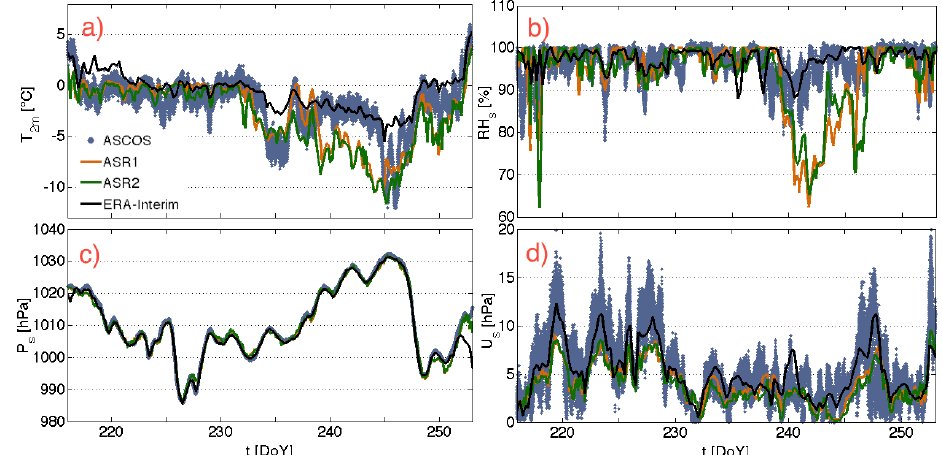
Fig. 4. Time series of near-surface variables for the entire ASCOS expedition showing (a) 2m temperature in ◦ C, (b) relative humidity (RH) in %, (c) surface pressure in hPa, and (d) scalar wind speed in ms − 1 , all of which as a function of the time in day of year (DoY) 2008. Each panel shows observations (grey) and interpolated model results from ASR1 (orange), ASR2 (green) and ERA-Interim (back). This color scheme applies throughout all